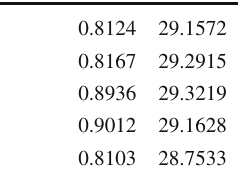
Table 6 Encryption time comparison(s)